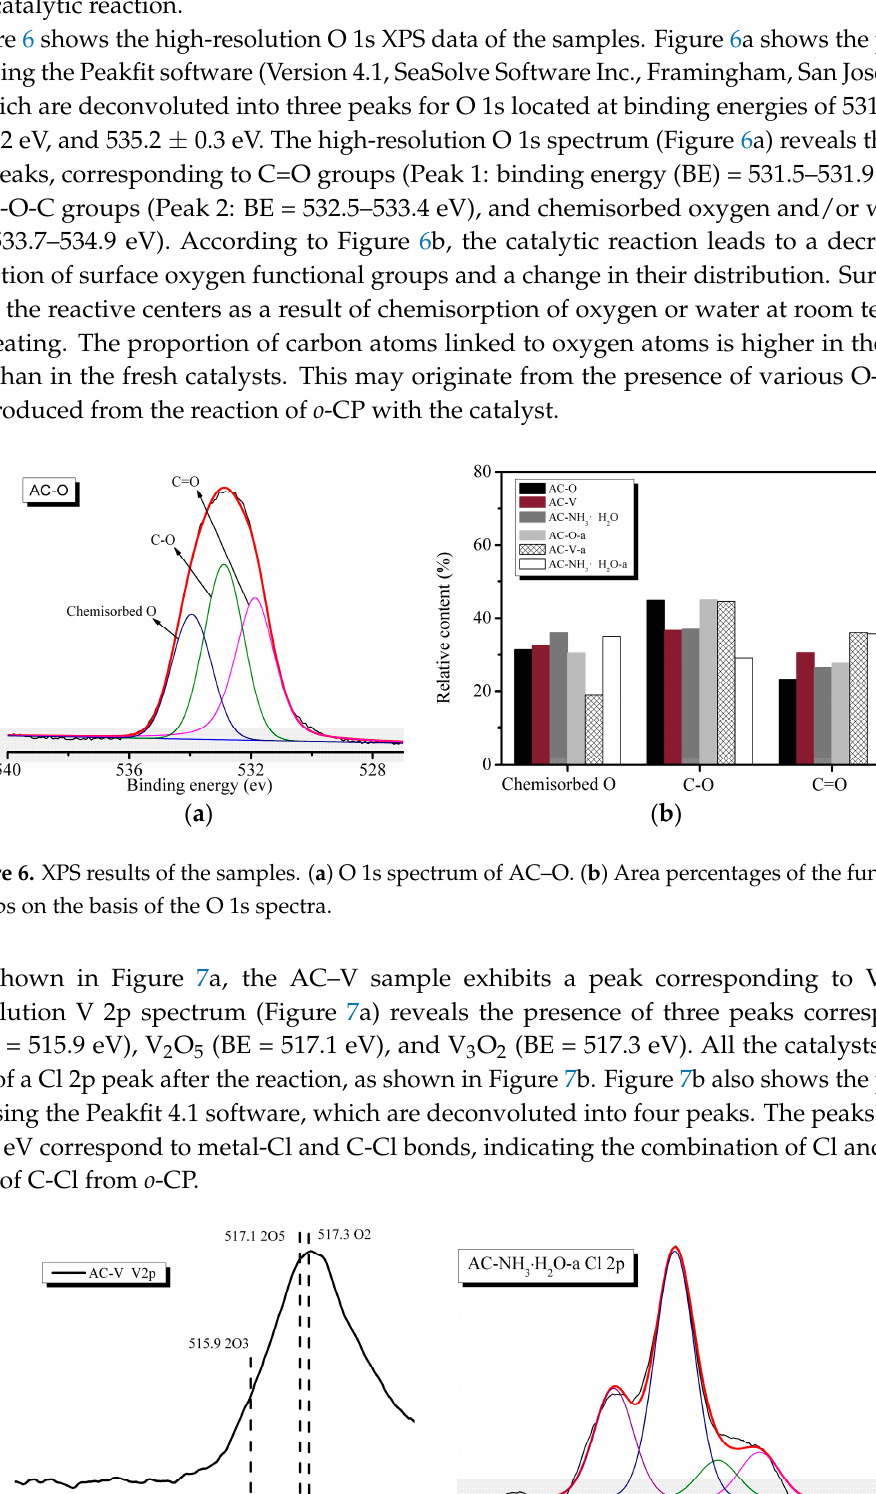
Figure 7. XPS spectra of AC–V: ( a ) V 2p and ( b ) Cl 2p.